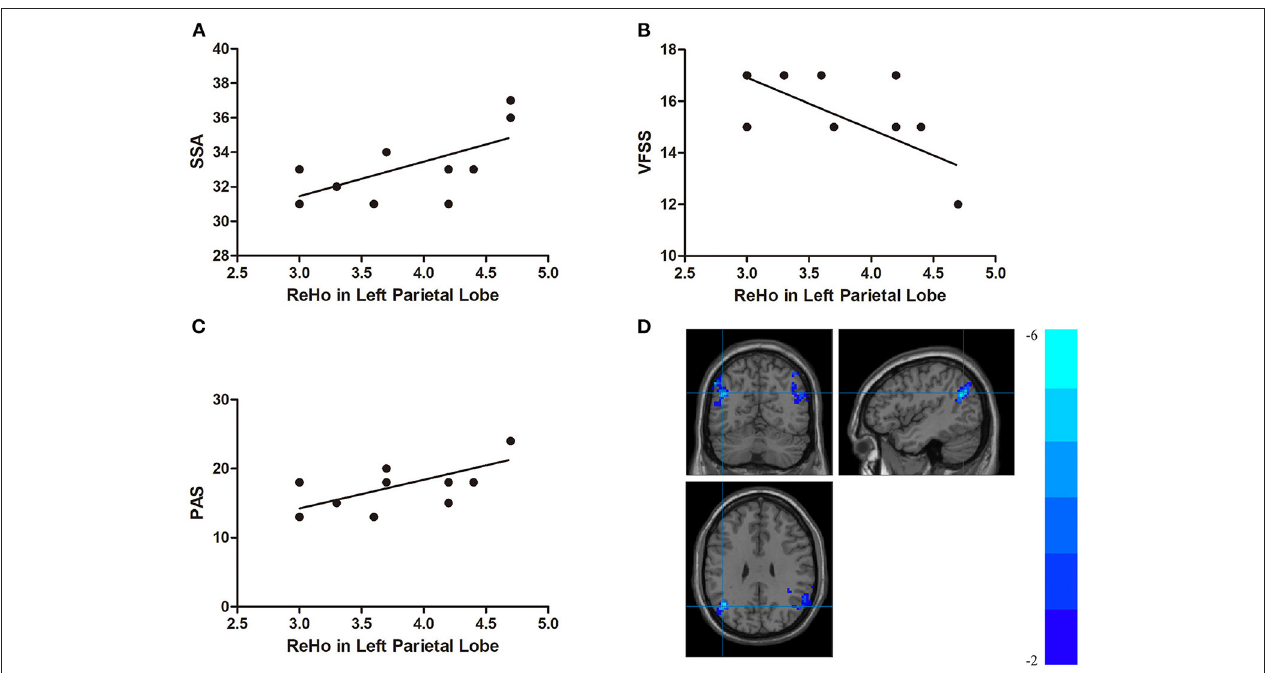
FIGURE 5 | (A) Correlations between the Standardized Bedside Swallowing Assessment (SSA) score and decreased ReHo in the left parietal lobe; (B) Correlations between Videofluoroscopic Swallowing Study (VFSS) score and decreased ReHo in the left parietal lobe; (C) Correlations between Penetration-Aspiration Scale (PAS) score and decreased ReHo in the left parietal lobe; (D) Regions exhibited in the left parietal lobe [ p < 0.001 corrected by Gaussian random field (GRF)].